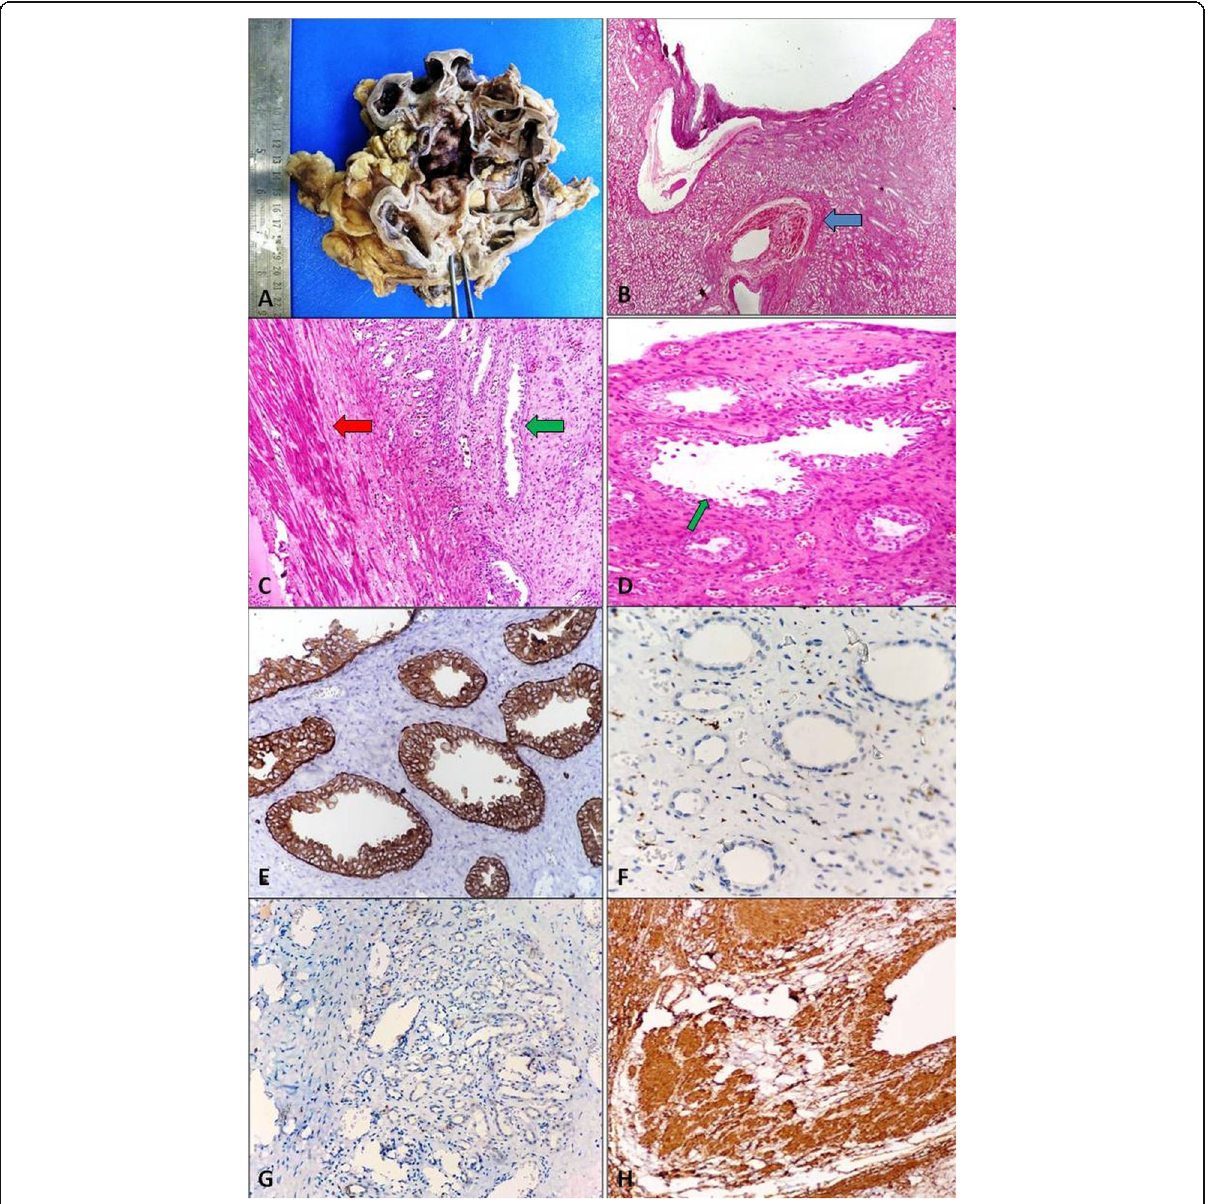
Fig. 2 Histopathological examination of renal angiomyoadenomatous tumor (RAT): gross image demonstrating multiple interconnecting cystic spaces with intervening thickened areas with patchy hemorrhagic areas ( a ). Hematoxylin and eosin (H&E) stained lower magnification image showing cystic spaces (epithelial component) along with thick-walled blood vessels (blue arrow) in renal parenchyma ( b , h & e , × 40). Epithelial component arranged in adenomatous/glandular/tubular pattern with basally located bland small beaded nuclei and intimately surrounded by thin vascular channels. The cytoplasm of the cells is optically clear with blisters like apical snouts giving the appearance of “ Shark ’ s Smile/moth- eaten ” (green arrow). Stromal smooth muscle component (red arrow) (H&E; × 100, c ; and × 400, d ). The epithelial component is immunopositive for pan-cytokeratin ( e , × 400), immunonegative for CD10 ( f , × 400), and immunonegative for HMB-45 ( g , × 40). The stromal smooth muscle was immunopositive for smooth muscle actin (SMA) ( h , ×